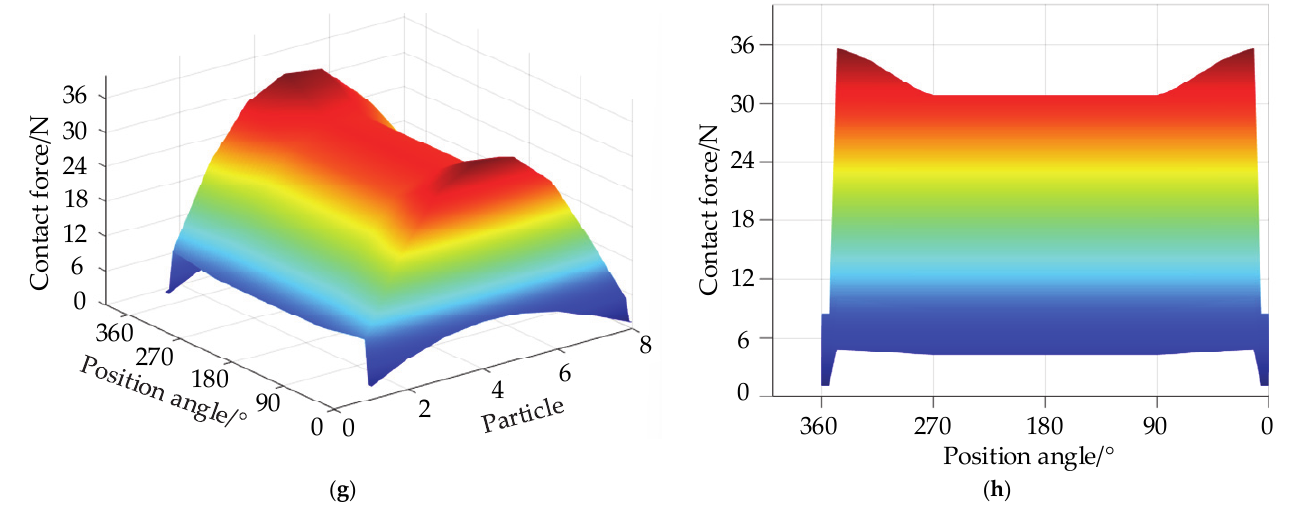
Figure 12. Internal force distribution of particles in each layer: ( a ) three-dimensional diagram of the second layer; ( b ) main view of the second layer; ( c ) three-dimensional diagram of the third layer; ( d ) main view of the third layer; ( e ) three-dimensional diagram of the fourth layer; ( f ) main view of the fourth layer; ( g ) three-dimensional diagram of the fifth layer; and ( h ) main view of the fifth layer.